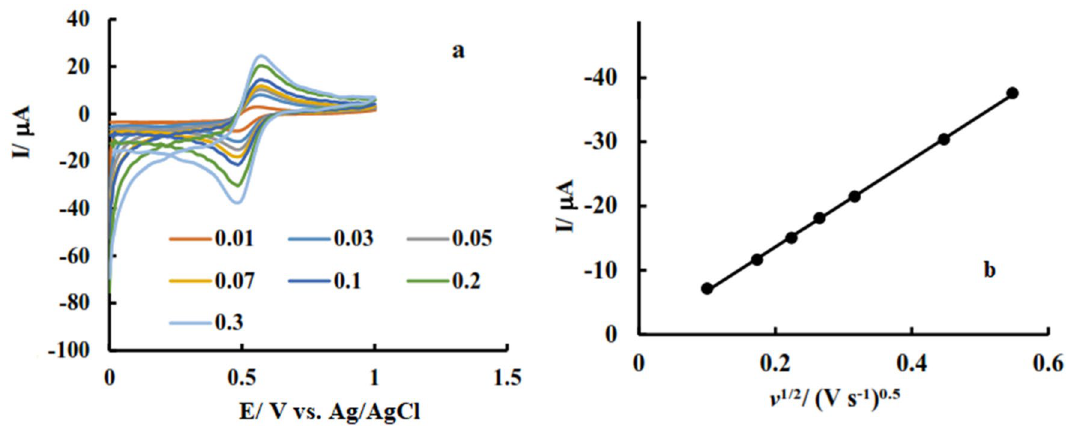
Figure 6. ( a ) Cyclic voltammograms of N, S-GQD/GCE in 0.5 M KNO 3 containing 25 µM Fe(III) with various scan rates; ( b ) Variation of current versus square root of scan